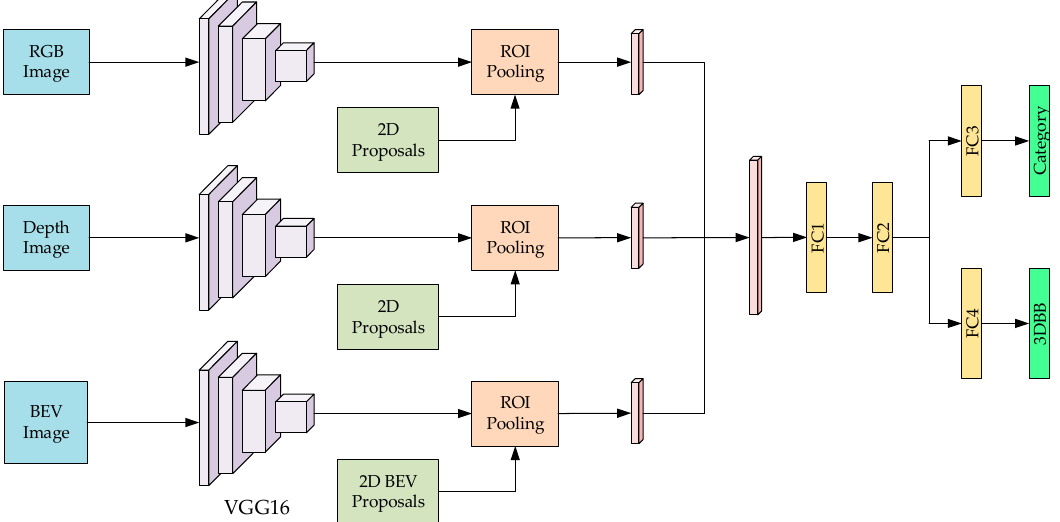
Figure 1. Multi-channel 3D object detection CNN architecture (ROI: region of interest, 3DBB: 3D bounding box).